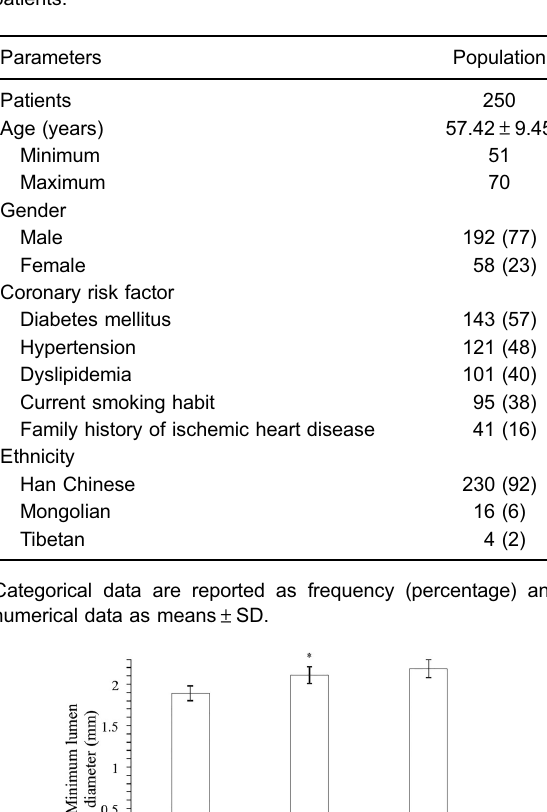
Table 2. Demographical and clinical conditions of the enrolled patients.